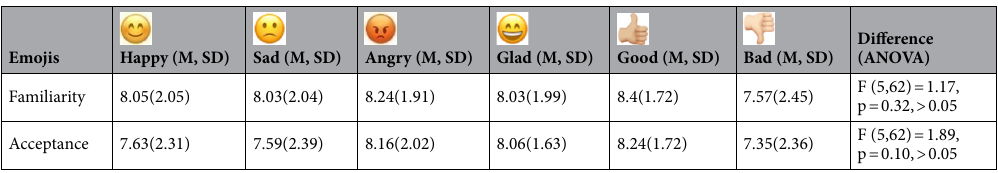
Table 1. Ranking results of emojis in the experiment.